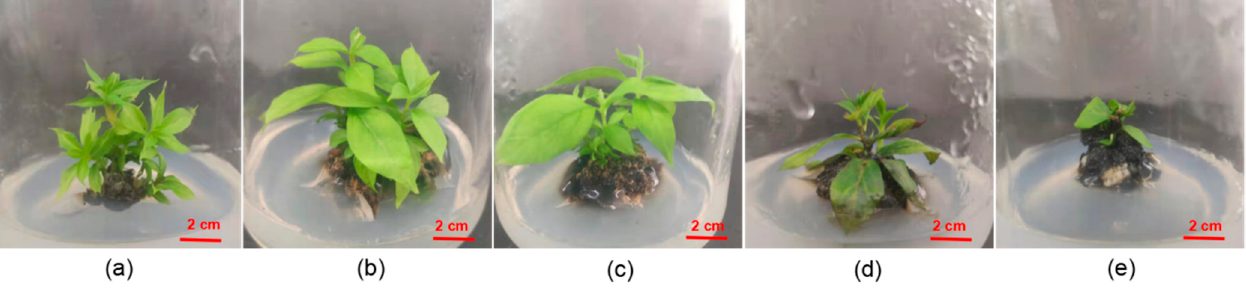
Figure 4. Growth of a callus after multiple inductions of adventitious shoots. Callus-induced adventitious shoot growth: ( a ) generation 1, ( b ) generation 2, ( c ) generation 3, ( d ) generation 4, and ( e ) generation 5.